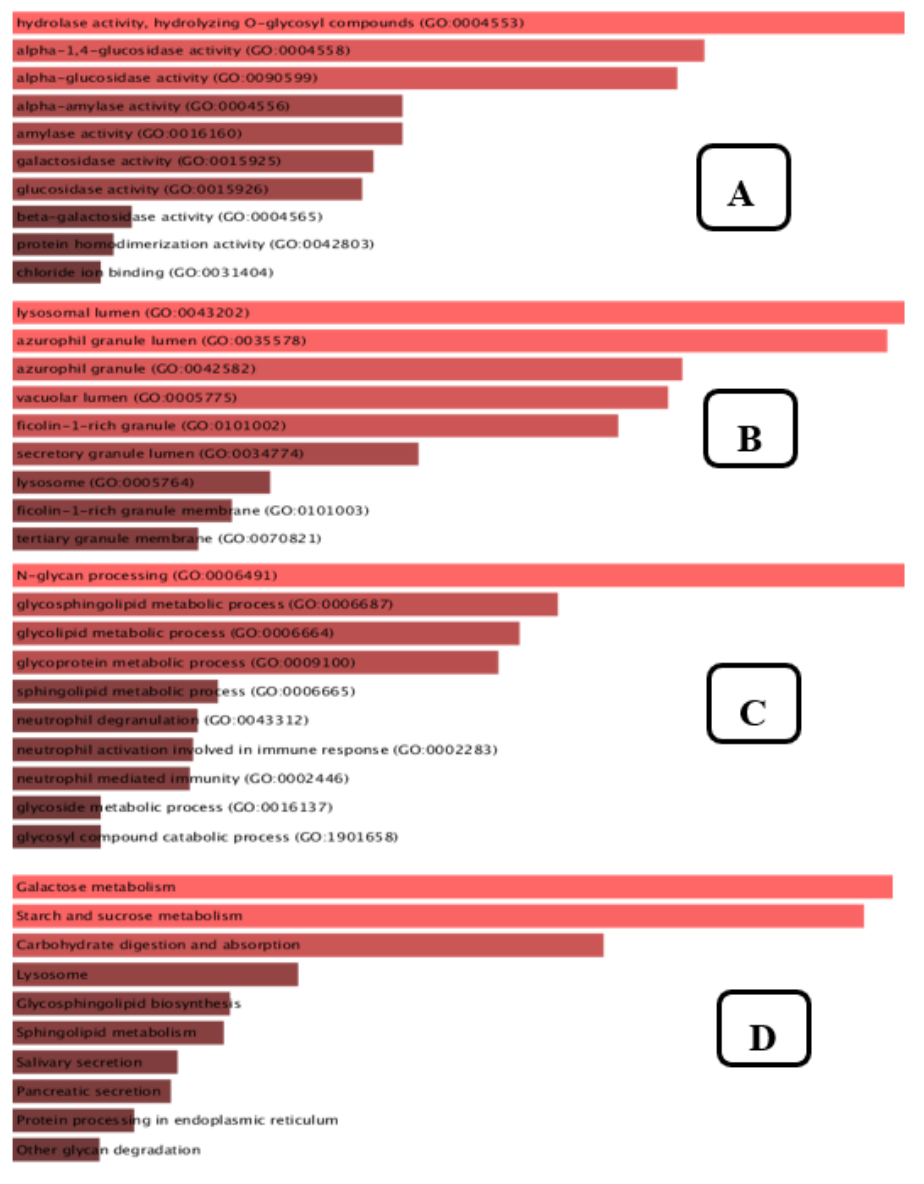
Figure 13. GO Molecular function ( A ), GO cellular component ( B ), GO Biological Process ( C ), KEGG pathway 2021 ( D ).